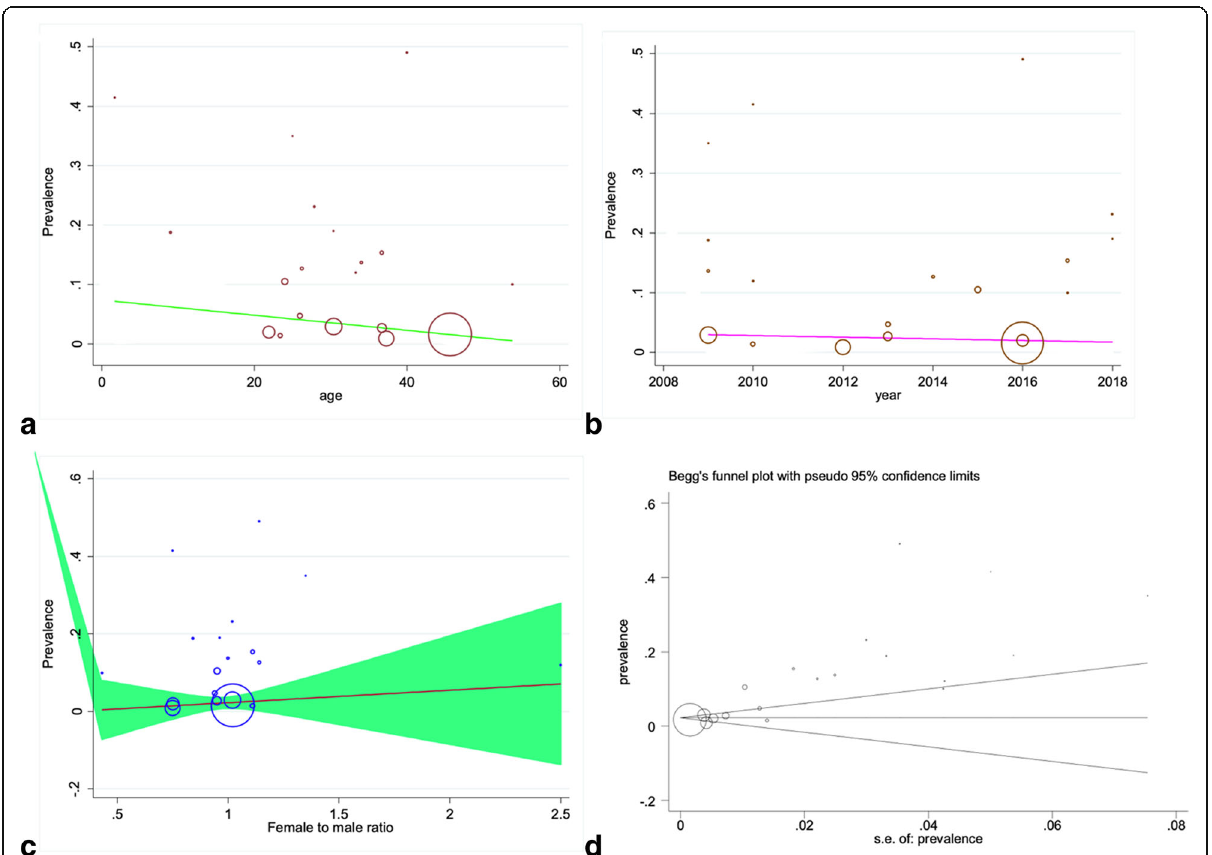
Fig. 9 Meta-regression between age ( a ) and sex( c ) of the participants and publication year ( b ) and prevalence of epilepsy surgery complications. Begg ’ s funnel plot ( d